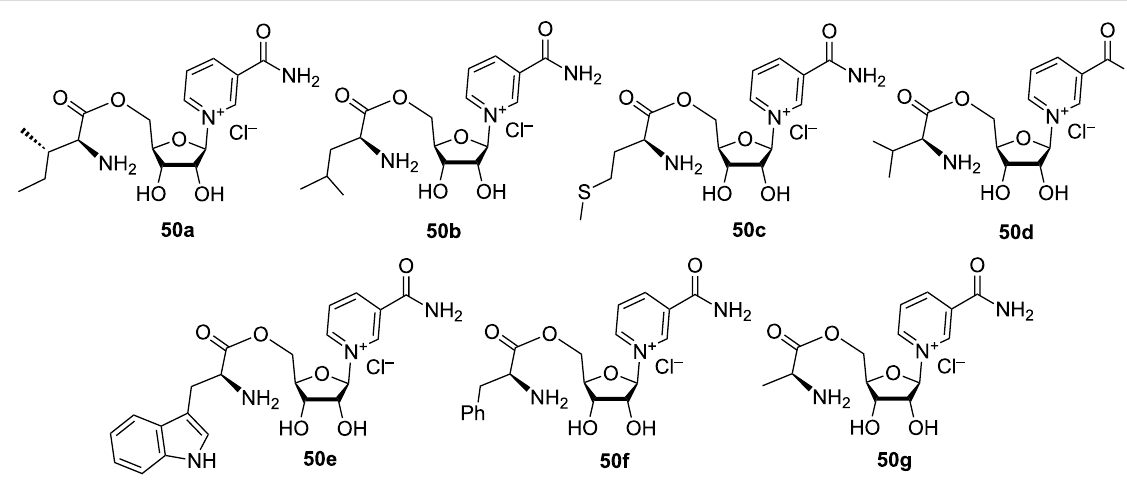
Figure 11: Structural formulas of amino acid NR +